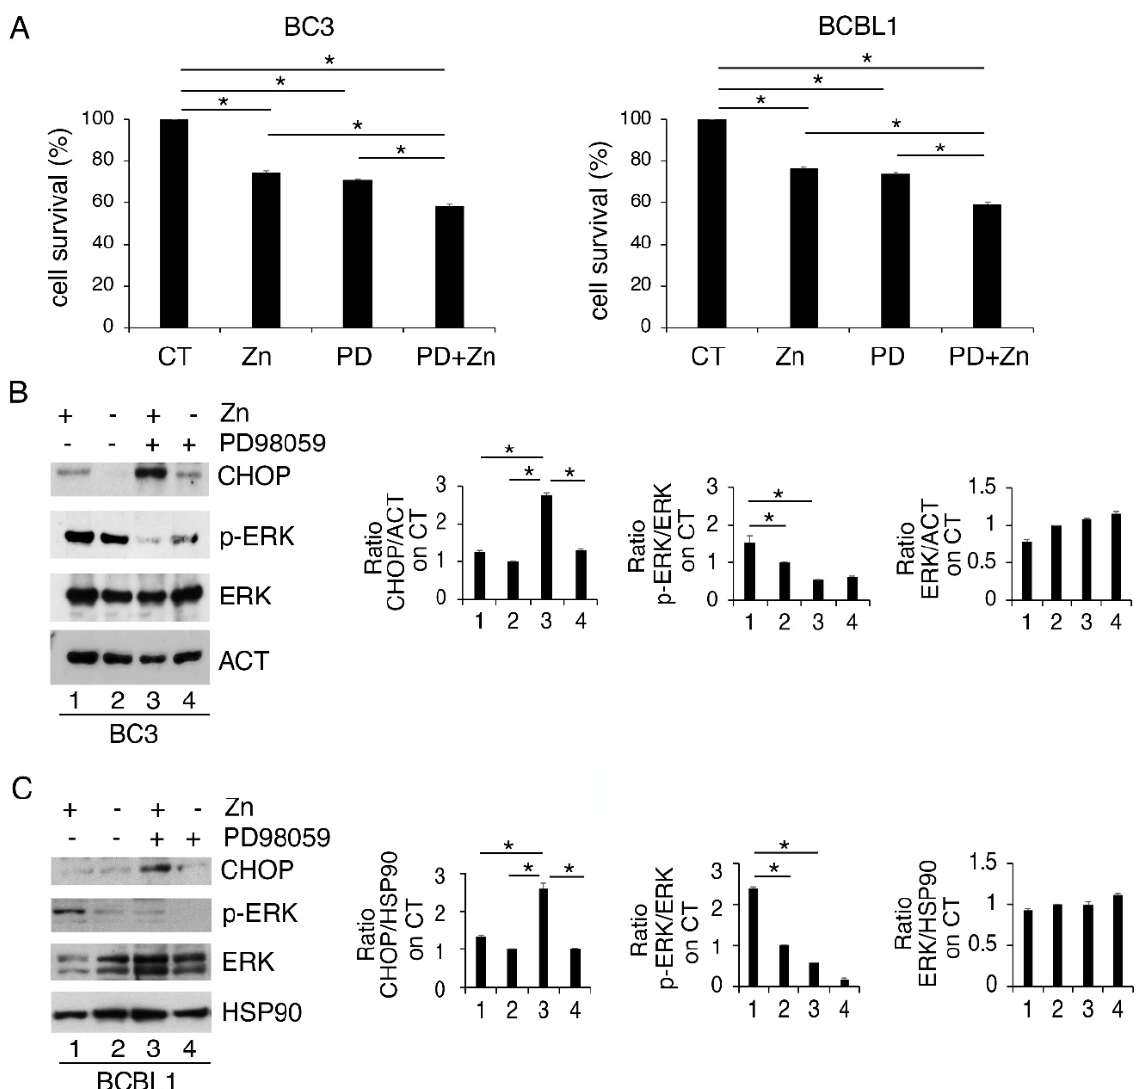
ER stress correlated with its mediated CHOP downregulation [26].